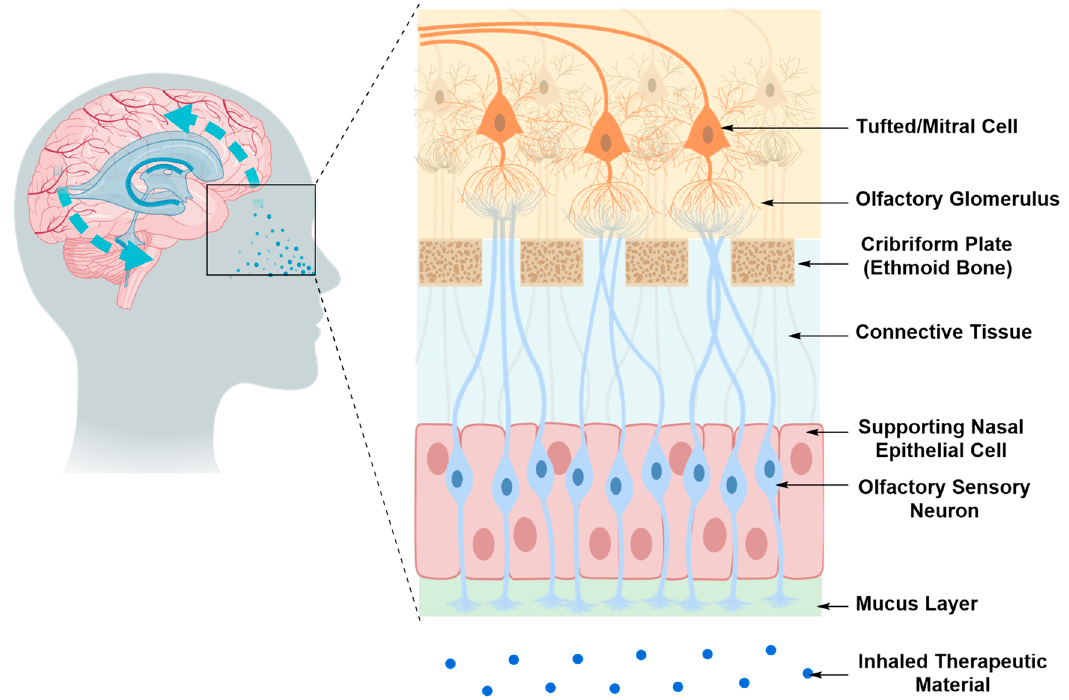
Figure 5. Direct nose-to-brain access via the olfactory pathway. The therapeutic material injected into the nasal cavity diffuses through the olfactory sensory nerves and olfactory glomeruli via passive or active transport mechanisms. It then reaches brain tissues via projection neurons, tufted or mitral cells.